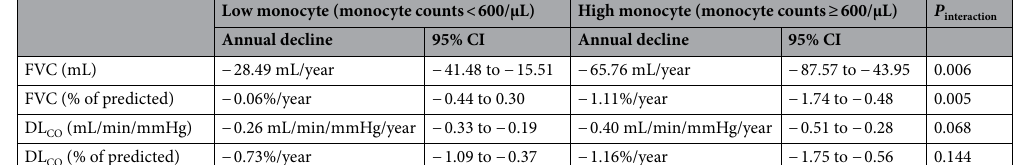
Low monocyte (monocyte counts < 600/µL) High monocyte (monocyte counts ≥